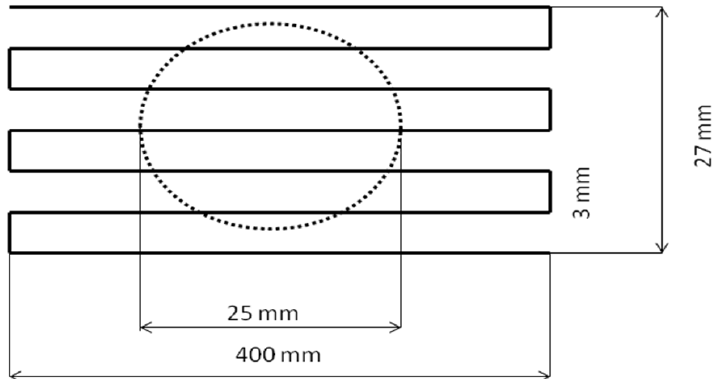
Figure 4. The trajectory of the torch in the calorimetric